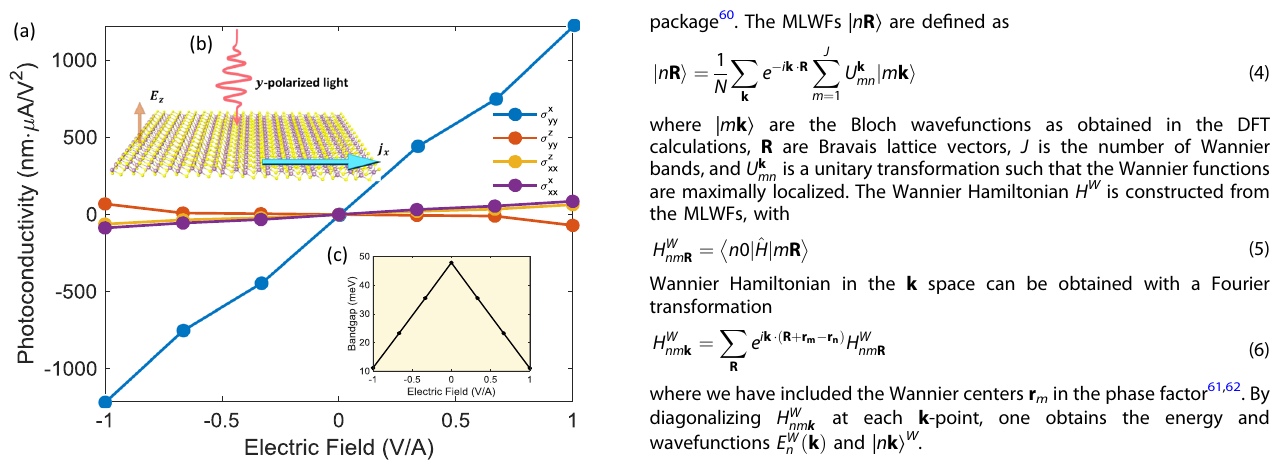
Fig. 7 Shift current conductivity of 1T ′ MoS 2 under external electric fi eld. a The SC conductivity of 1T ′ pristine MoS 2 as a function of out-of-plane electric fi eld. The out-of-plane electric fi eld breaks the inversion symmetry and the photocurrent fl ip direction when the direction of the electric fi eld is fl ipped. Inset b : A schematic illustration of the system: A PTMD is under an out-of- plane electric fi eld + E z . A light polarized in y direction shines on the PTMD and a current in the + x direction j x is induced from the non- zero σ x yy . The direction of the current would fl ip to − x if the out-of- plane electric fi eld is fl ipped to − E z . Inset c : bandgap of 1T ′ MoS 2 as a function of out-of-plane electric fi